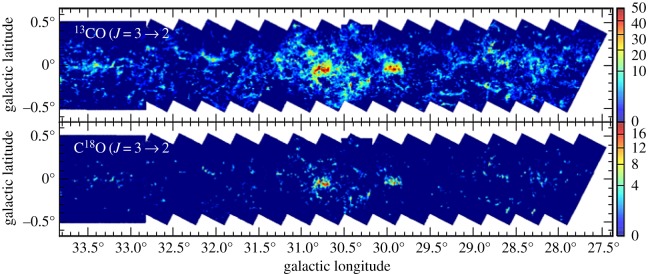
Part of the CHIMPS survey of the Galactic Plane. (a) Velocity integrated emission of 13CO(3–2) and (b) the same for C18O(3–2). Adapted from Rigby et al. [196].